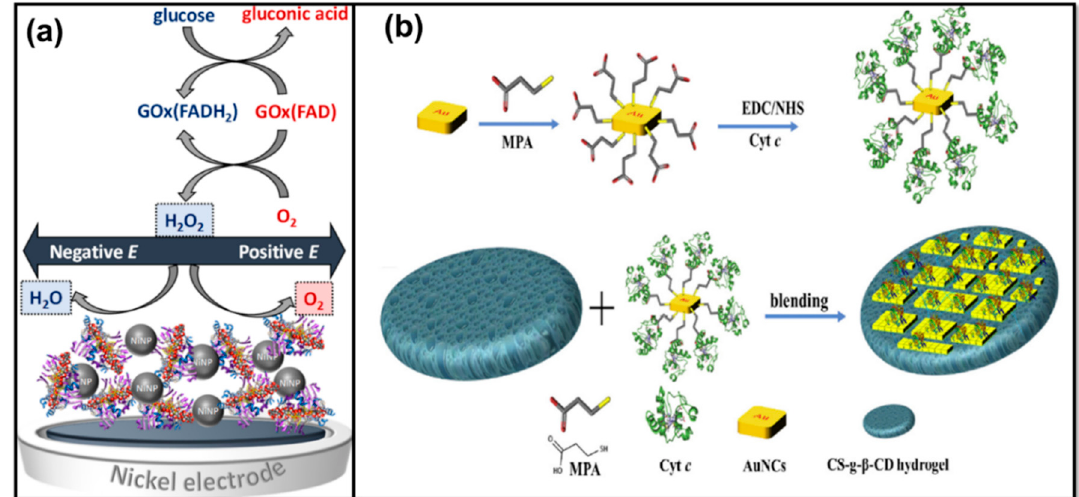
Figure 18. Electrode fabrication process and detection of glucose and H 2 O 2 . ( a ) the possible mechanism for the simultaneous oxidation of H 2 O 2 and glucose molecules by NiNP / Ni substrate-based enzymatic ECB [179]. ( b ) The synthesis process for cyt c conjugated AuNCs imbedded hydrogel ECB for the sensitive detection of H 2 O 2 [182]. Reprinted with permission from [179], Copyright © 2020